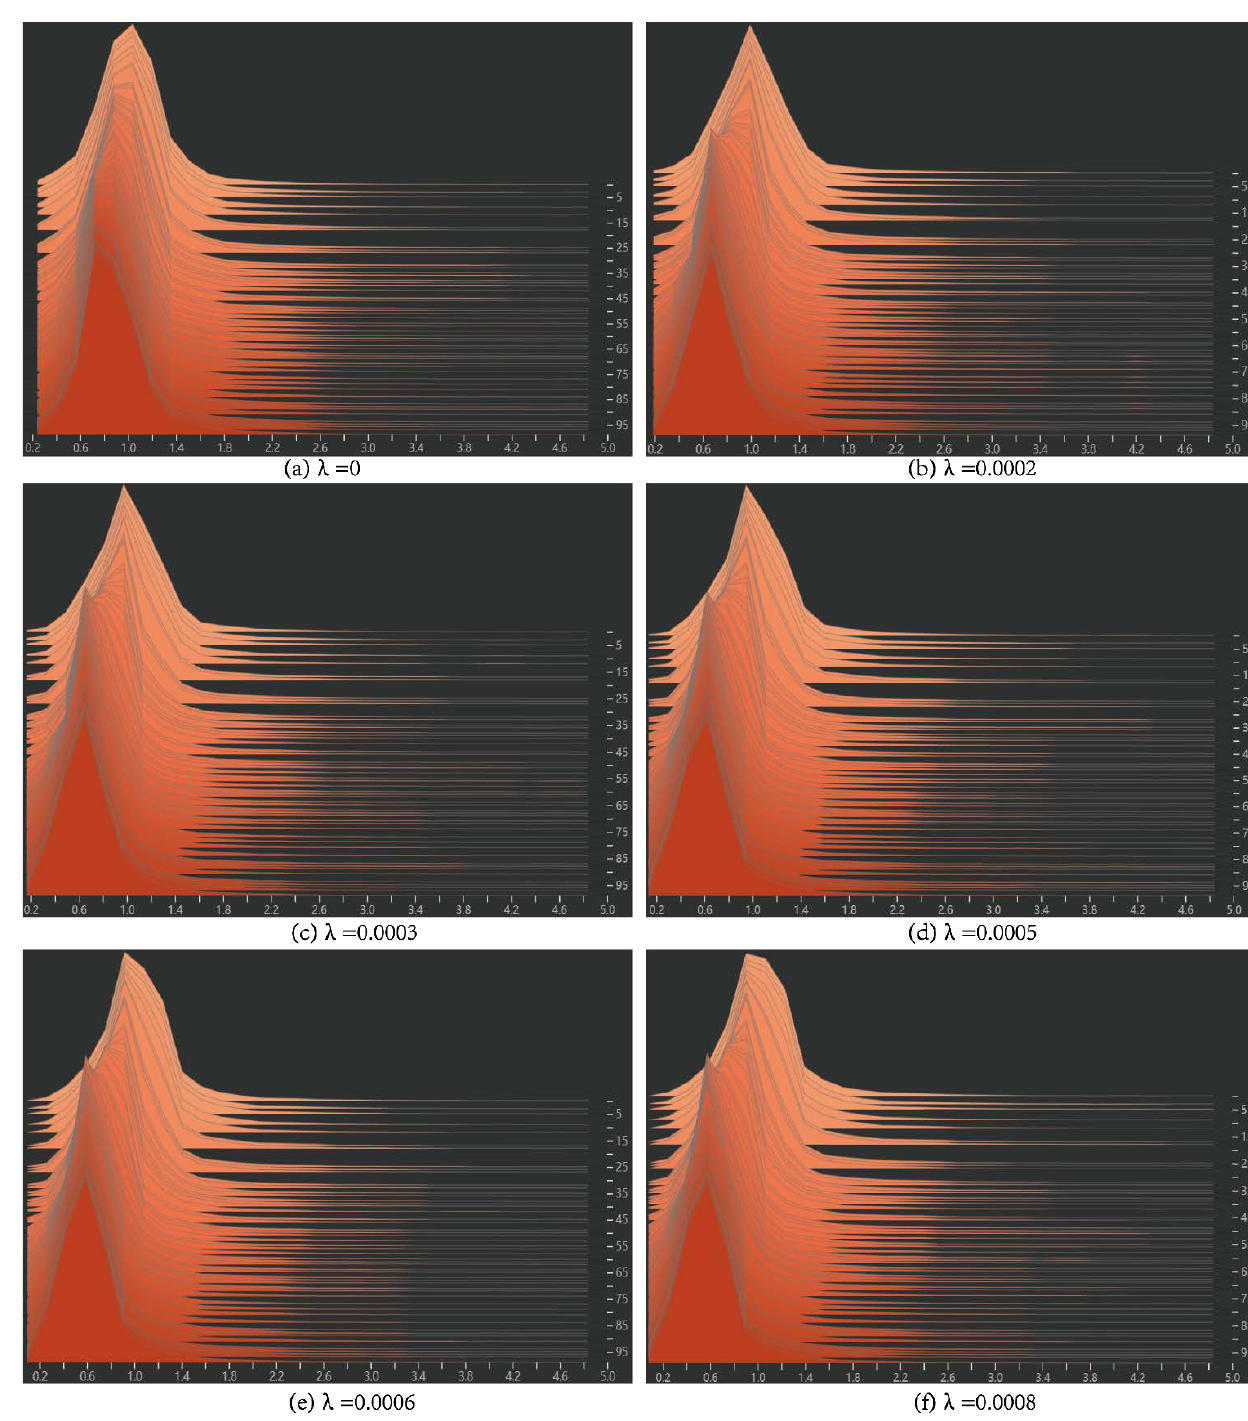
Figure 16. The data distribution of the BN layer when λ changes from 0 to 0.0008 .